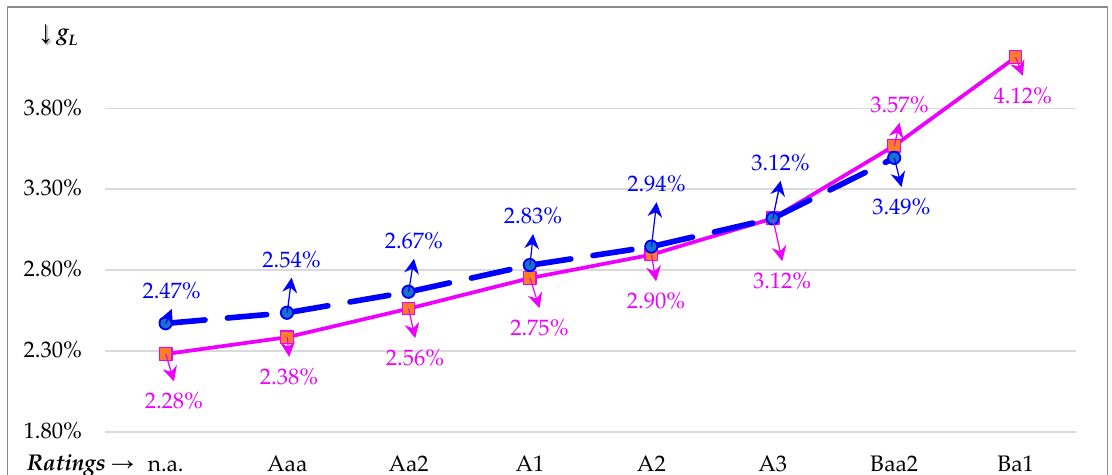
Figure 5. Levered equity growth rate ( g L ) values are plotted along vertical axis against Moody’s credit ratings along horizontal axis. The nonprofit trajectory is the solid line and the pass-through trajectory is the dashed line. We use credit spreads for 2019, TCJA low ( L ) tax rates, and 3.12% growth where the growth ( RE ) constraint sets in after Ba1 for nonprofits (NPs) and after Ba2 for pass-throughs (PTs). The optimal credit rating ( OCR ) is A3.